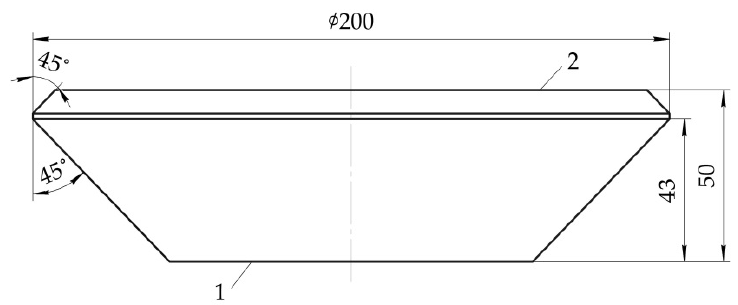
Figure 7. Test specimen of translucent element: 1—low-pressure side; 2—high-pressure side.